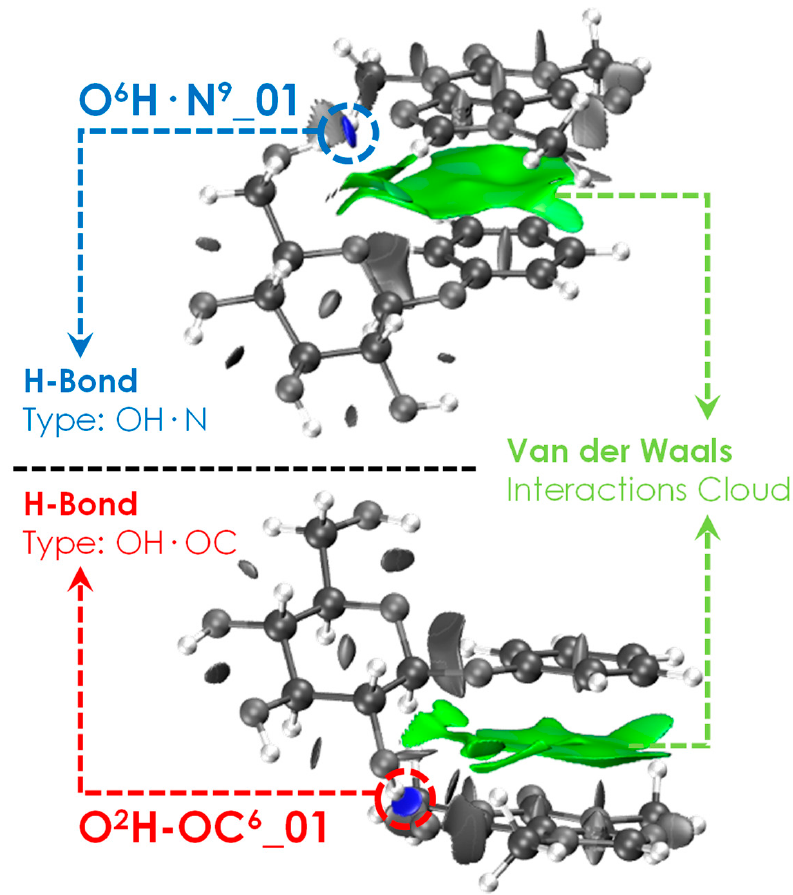
Figure 5. NCI plots (iso value s = 0.5) of the most stable (RE: O 6 H · N 9 _01) and that of the most strongly bonded (BE: O 2 H · OC 6 _01) structures. The original pictures together with the 2D-graphics are reported in Figure S31.